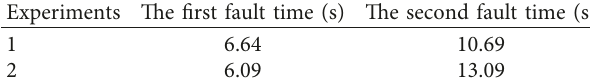
Table 3: Fault time of the two